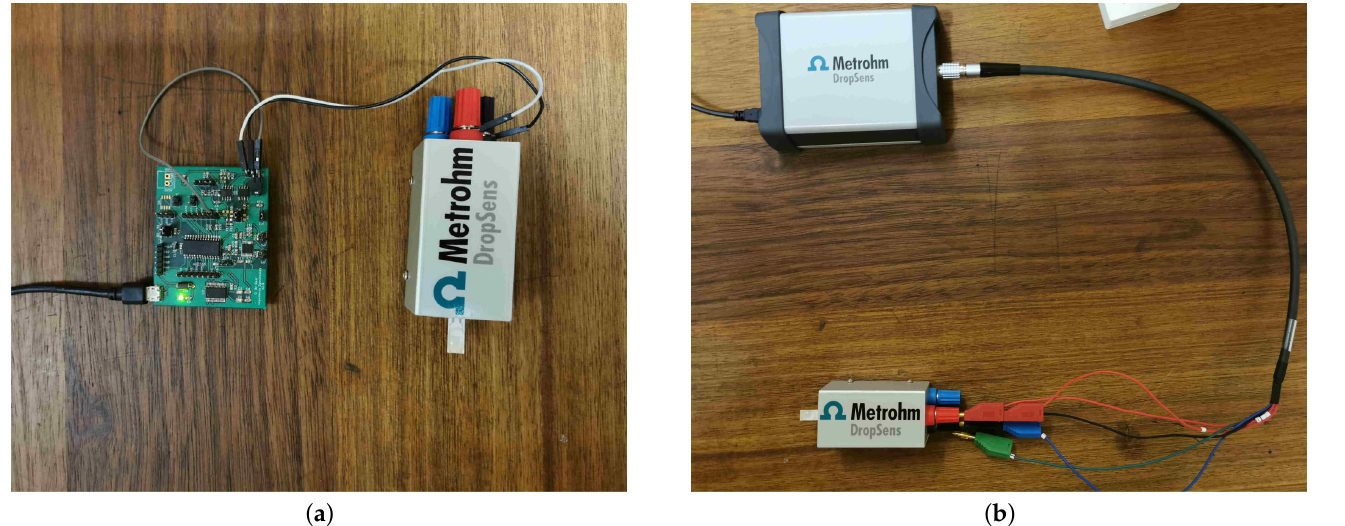
Figure 4. Experimental setup for two different impedance solutions. Both solutions make use of same elec- trode and boxed connector, which allows changing device connected to electrode without disturbing the electrode. ( a ) Low-cost impedance analyzer setup. ( b ) DropSens µStat-i 400s setup.